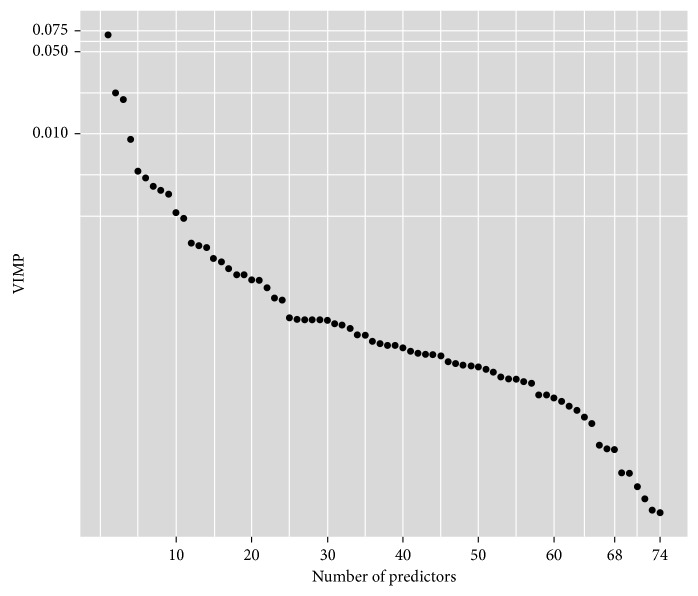
VIMP for predictors with VIMP > 0.